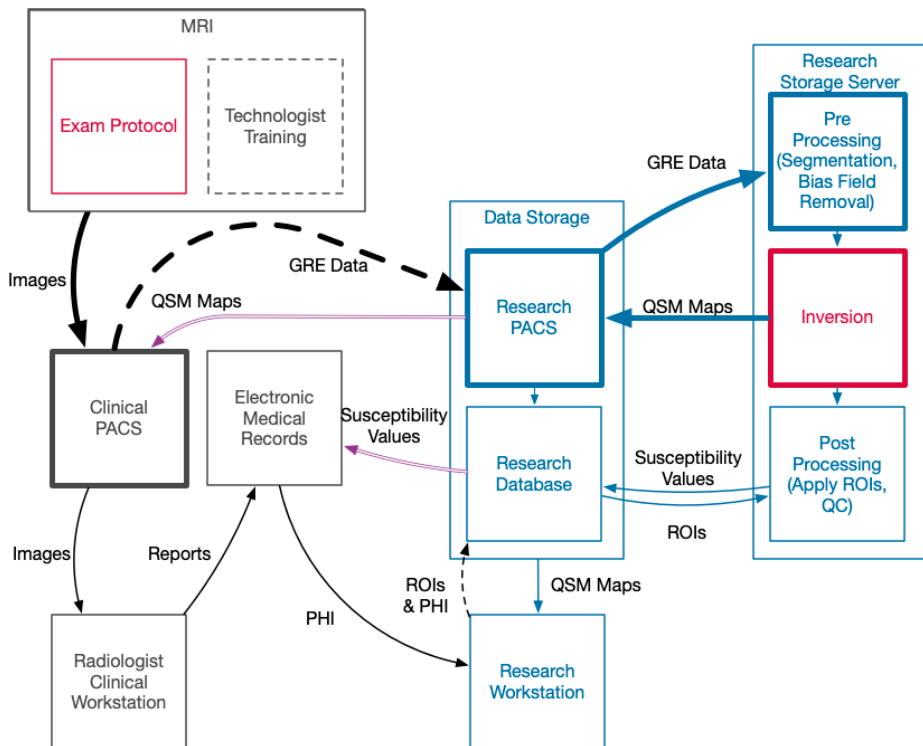
Figure 3. Diagram of data flow starting with acquisition. This process flow diagram shows a representative diagram of the key elements. The flow of data from acquisition to the generation of a QSM map is noted with bold lines. Red indicates aspects of QSM imaging covered in most imaging papers. Blue indicates research hardware, software, and data that facilitate the QSM imaging process. Purple indicates the clinically useful outputs of the research processing. Black are standard hospital systems and processes. Dashed lines indicate manual processes of training and data transfer wherein failures may cause data loss. Abbreviations: Magnetic Resonance Imaging (MRI), Gradient Recalled Echo (GRE), Picture Archive and Communication System (PACS), Quantitative Susceptibility Map (QSM), Quality Control (QC), Regions of Interest (ROI), Protected Health Information